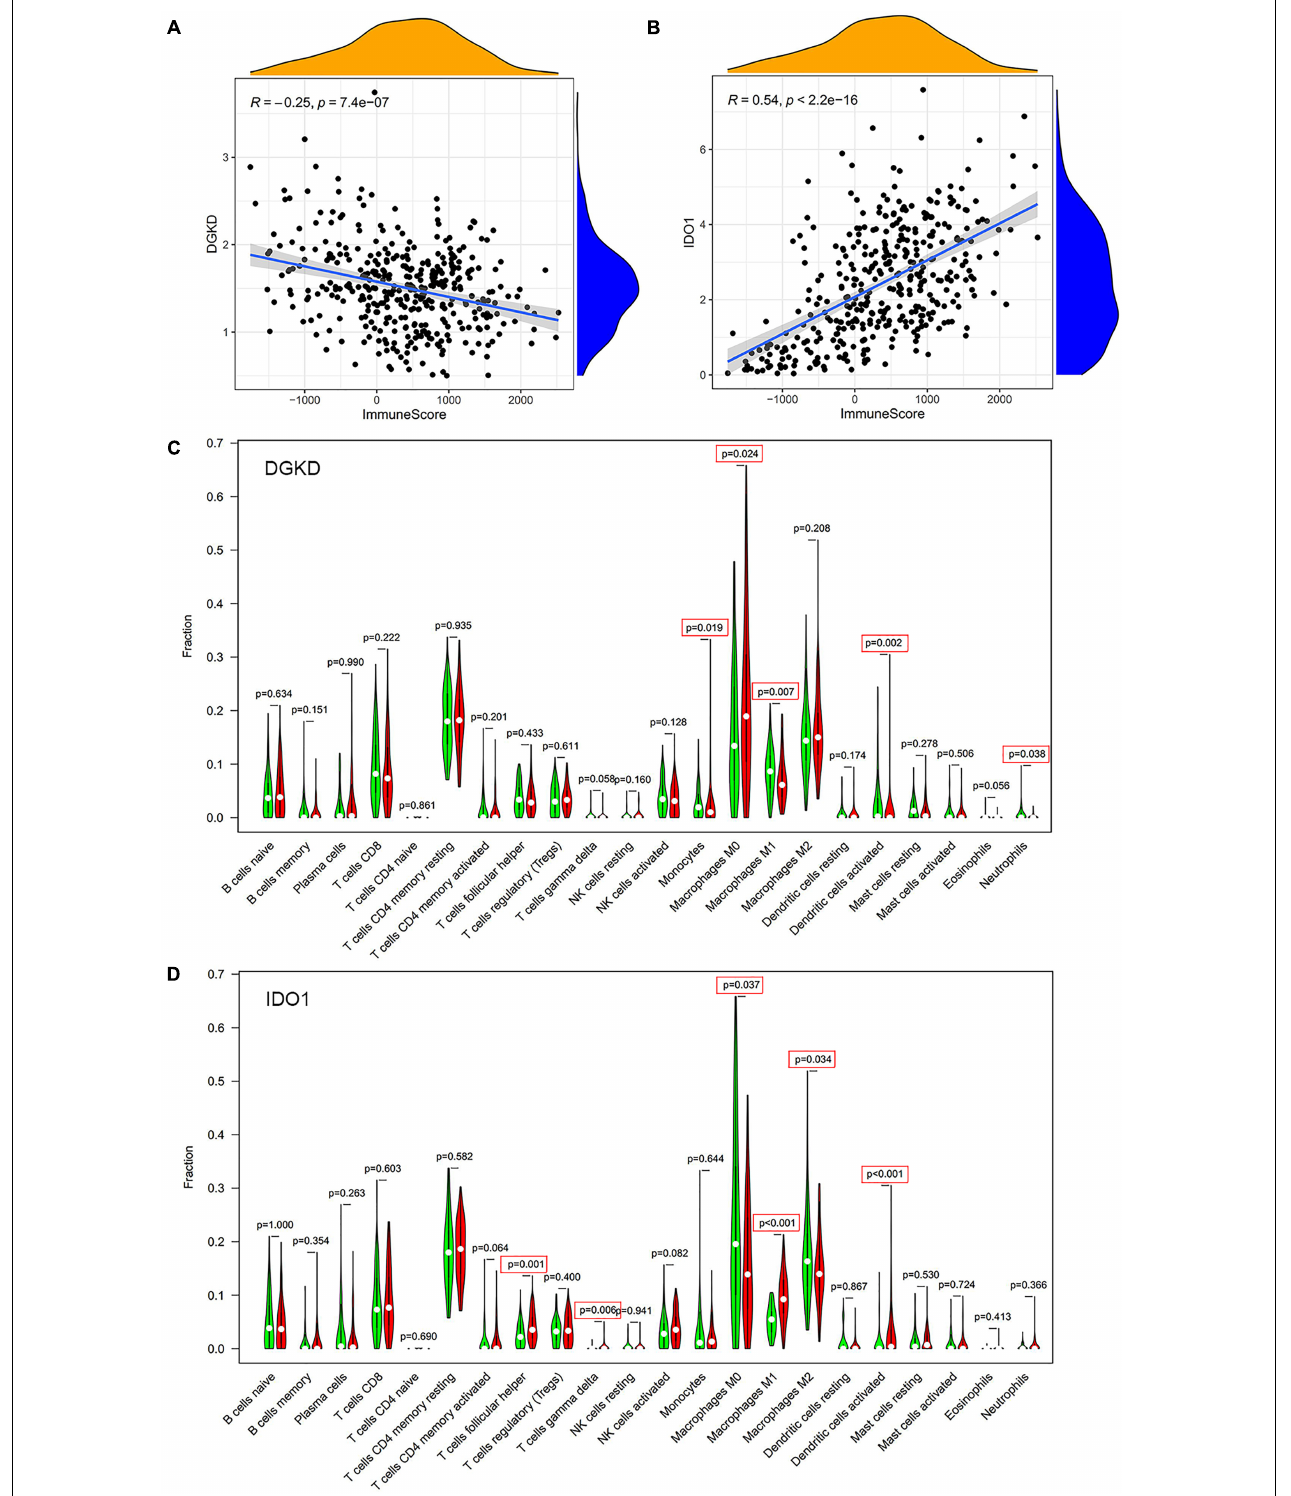
FIGURE 7 | Analysis of immune cells infiltration with DGKD and IDO1 expression in CIBERSORT database. The negative correlation of DGKD expression with immune cells (A) and the positive correlation of IDO1 expression with immune cells (B) . The Violin plot of immune cells between OC tumor samples with the low or high expression level of DGKD (C) and IDO1 (D) relative to its median expression level, respectively. Red, high expression; Green, low expression.